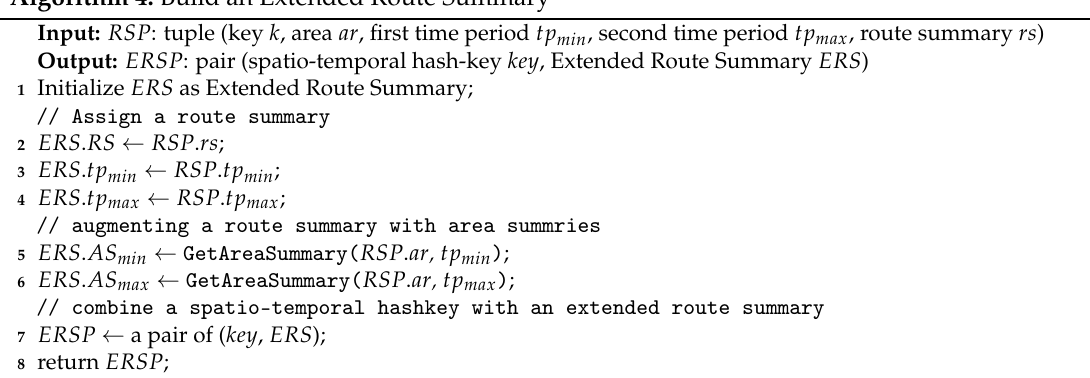
Algorithm 4: Build an Extended Route